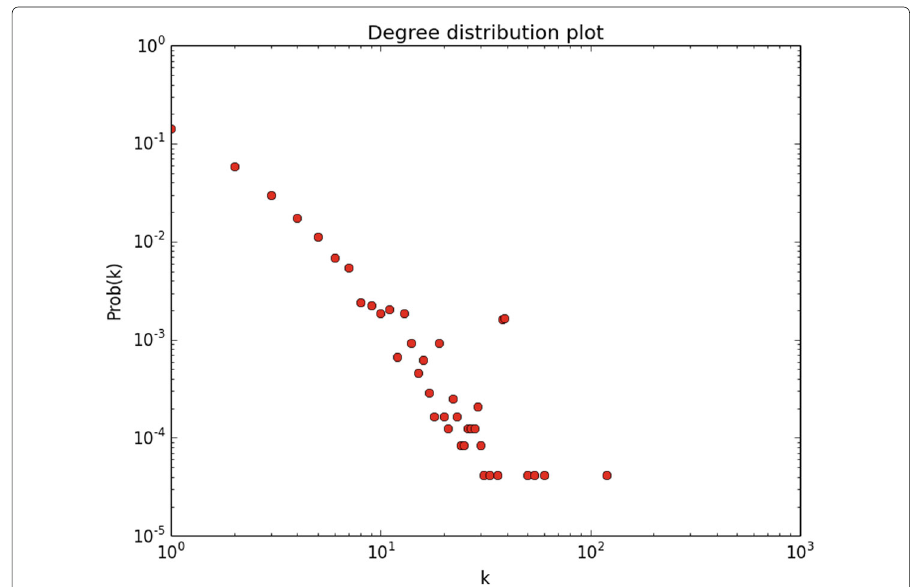
Fig. 6 Degree distribution of phone activity network